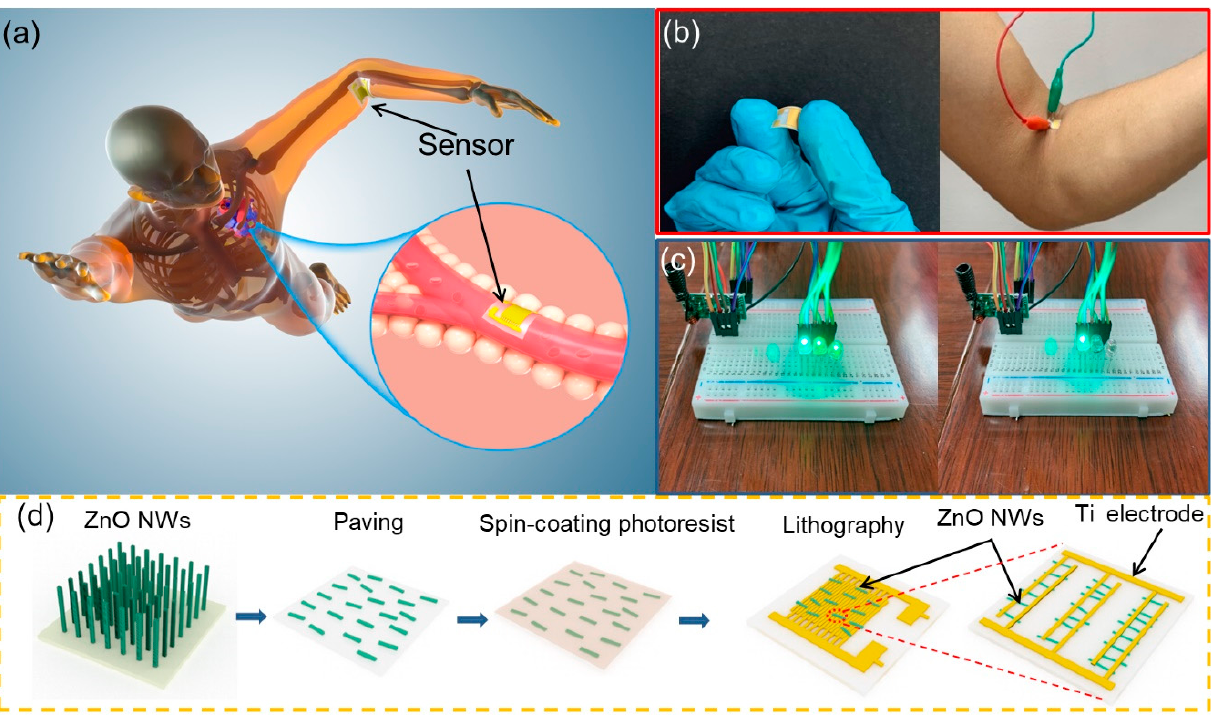
Figure 1. A potential scenario and the process of synthesis of self-powered biosensor in swimming monitoring. ( a ) Simulating the monitoring of athlete’s elbow joint angle and heart rate. ( b ) Optical image of biosensor. ( c ) Simple wireless transmitter and information receiver. ( d ) Process of synthesis of self-powered biosensor.